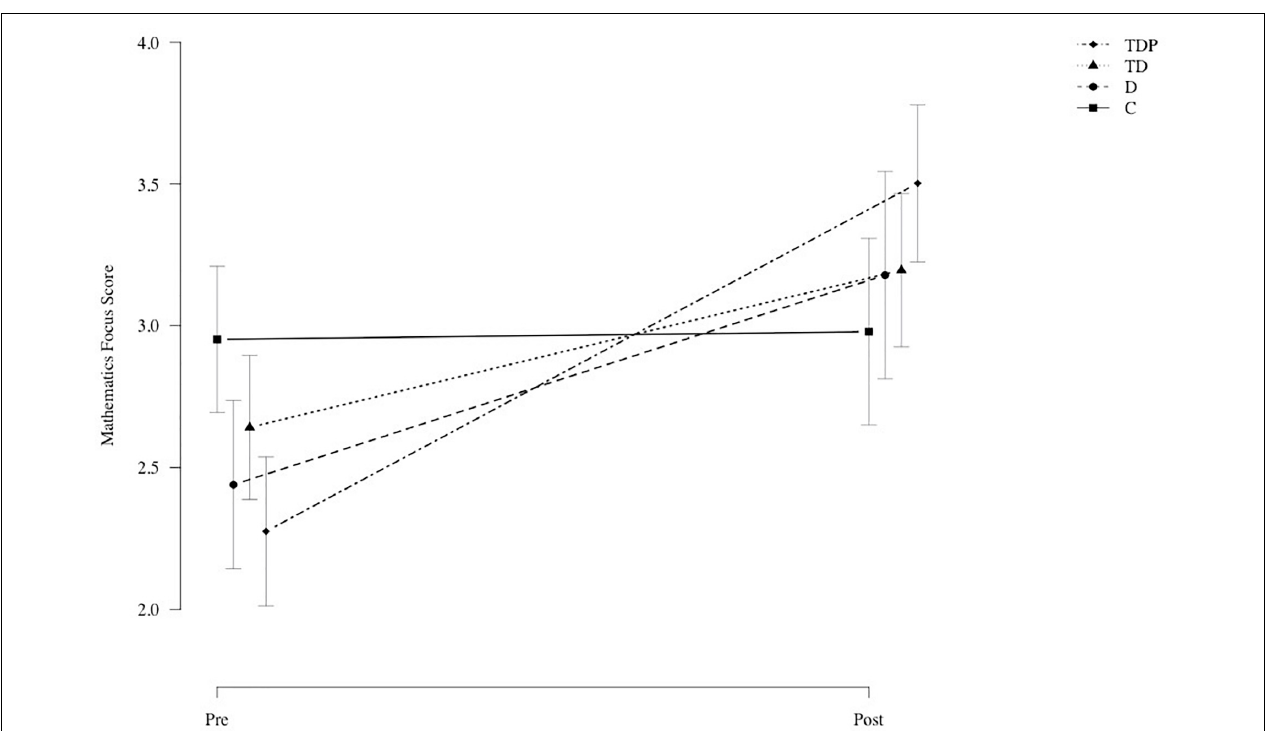
FIGURE 2 | Mathematics focus scores on pre- and post-tests for Groups C (control group), D (diary), TD (training + diary), and TDP (training + diary + peer feedback intervention).